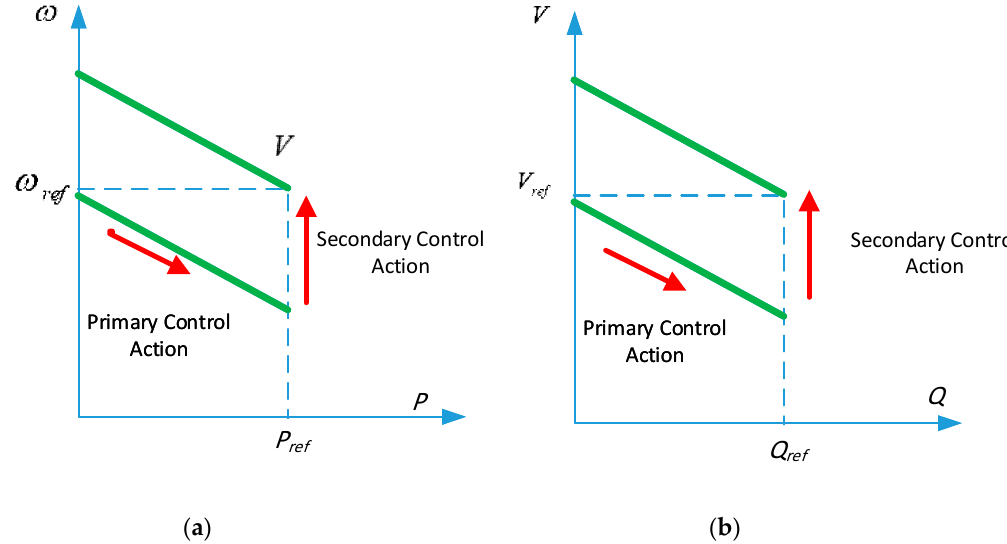
Figure 3. ( a ) ω –P droop characteristics of a microgrid and ( b ) V–P droop characteristics of microgrid.